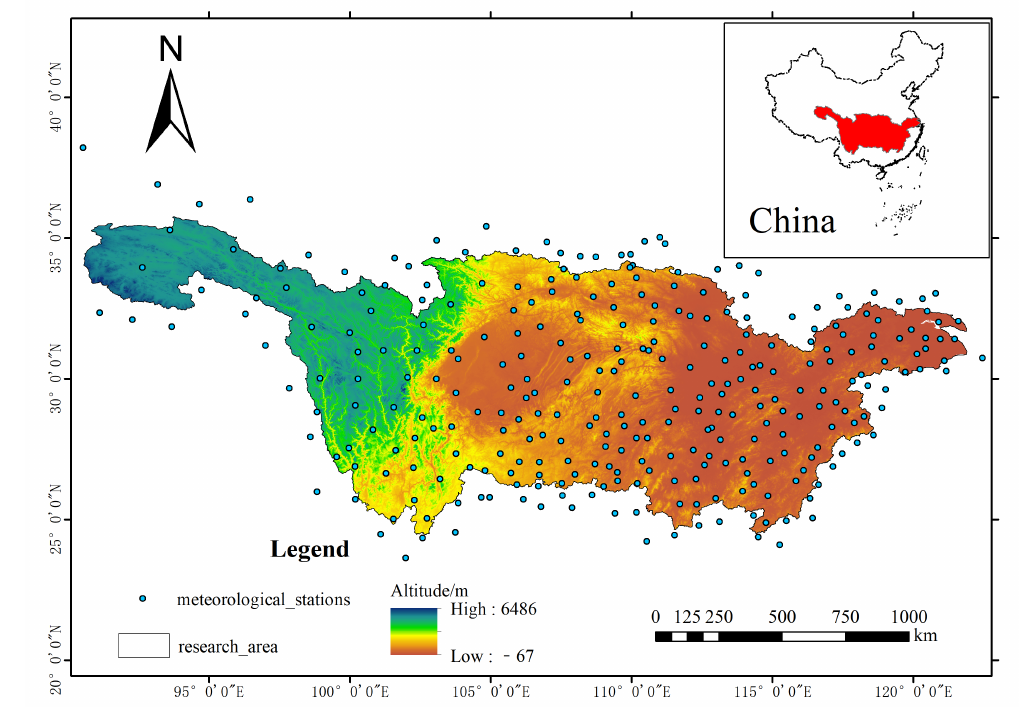
Figure 2. Distribution of meteorological stations in the Yangtze River